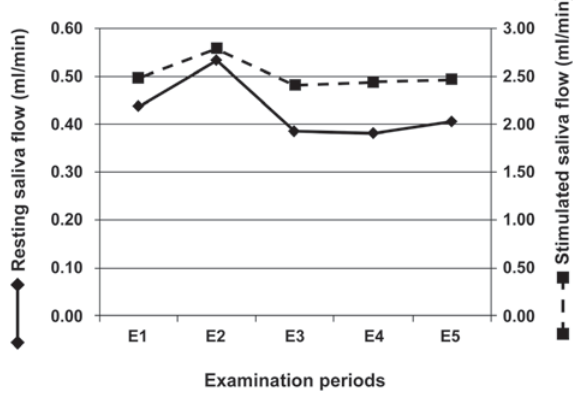
Figure 3- (cid:2) (cid:26)(cid:7)(cid:11)(cid:14)(cid:15)(cid:11)(cid:20)(cid:15)(cid:16)(cid:5)(cid:18)(cid:10)(cid:2) (cid:16)(cid:18)(cid:2) (cid:10)(cid:20)(cid:7)(cid:16)(cid:17)(cid:20)(cid:2) (cid:27)(cid:5)(cid:28)(cid:2) (cid:4)(cid:20)(cid:15)(cid:8)(cid:29)(cid:2) (cid:30)(cid:22)(cid:8)(cid:2) (cid:24)(cid:20)(cid:15)(cid:20)(cid:2) (cid:4)(cid:8)(cid:21)(cid:4)(cid:8)(cid:10)(cid:8)(cid:18)(cid:15)(cid:2)(cid:15)(cid:22)(cid:8)(cid:2)(cid:23)(cid:8)(cid:20)(cid:18)(cid:2)(cid:27)(cid:5)(cid:28)(cid:2)(cid:4)(cid:20)(cid:15)(cid:8)(cid:2)(cid:9)(cid:5)(cid:4)(cid:2)(cid:4)(cid:8)(cid:10)(cid:15)(cid:16)(cid:18)(cid:19)(cid:2)(cid:10)(cid:20)(cid:7)(cid:16)(cid:17)(cid:20)(cid:2)(cid:31)(cid:10)(cid:5)(cid:7)(cid:16)(cid:24)(cid:2)(cid:7)(cid:16)(cid:18)(cid:8)!(cid:2) and for stimulated saliva (broken line), respectively